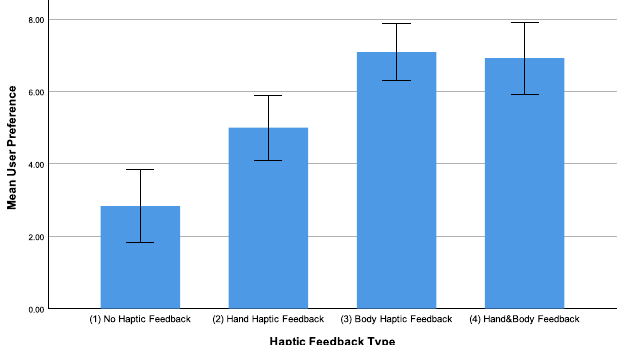
Figure 8. Mean user